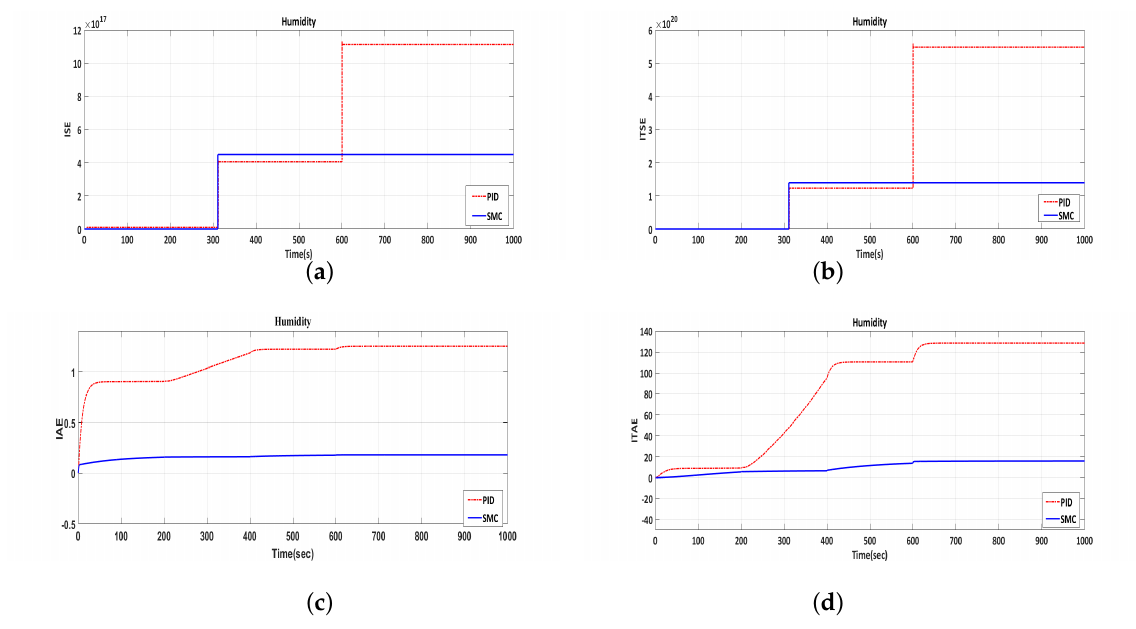
Figure A6. Performance indices ( a ) ISE, ( b ) ITSE, ( c ) IAE, ( d ) ITAE graph of controllers for humidity output, combination of ramp with steps and multilevel